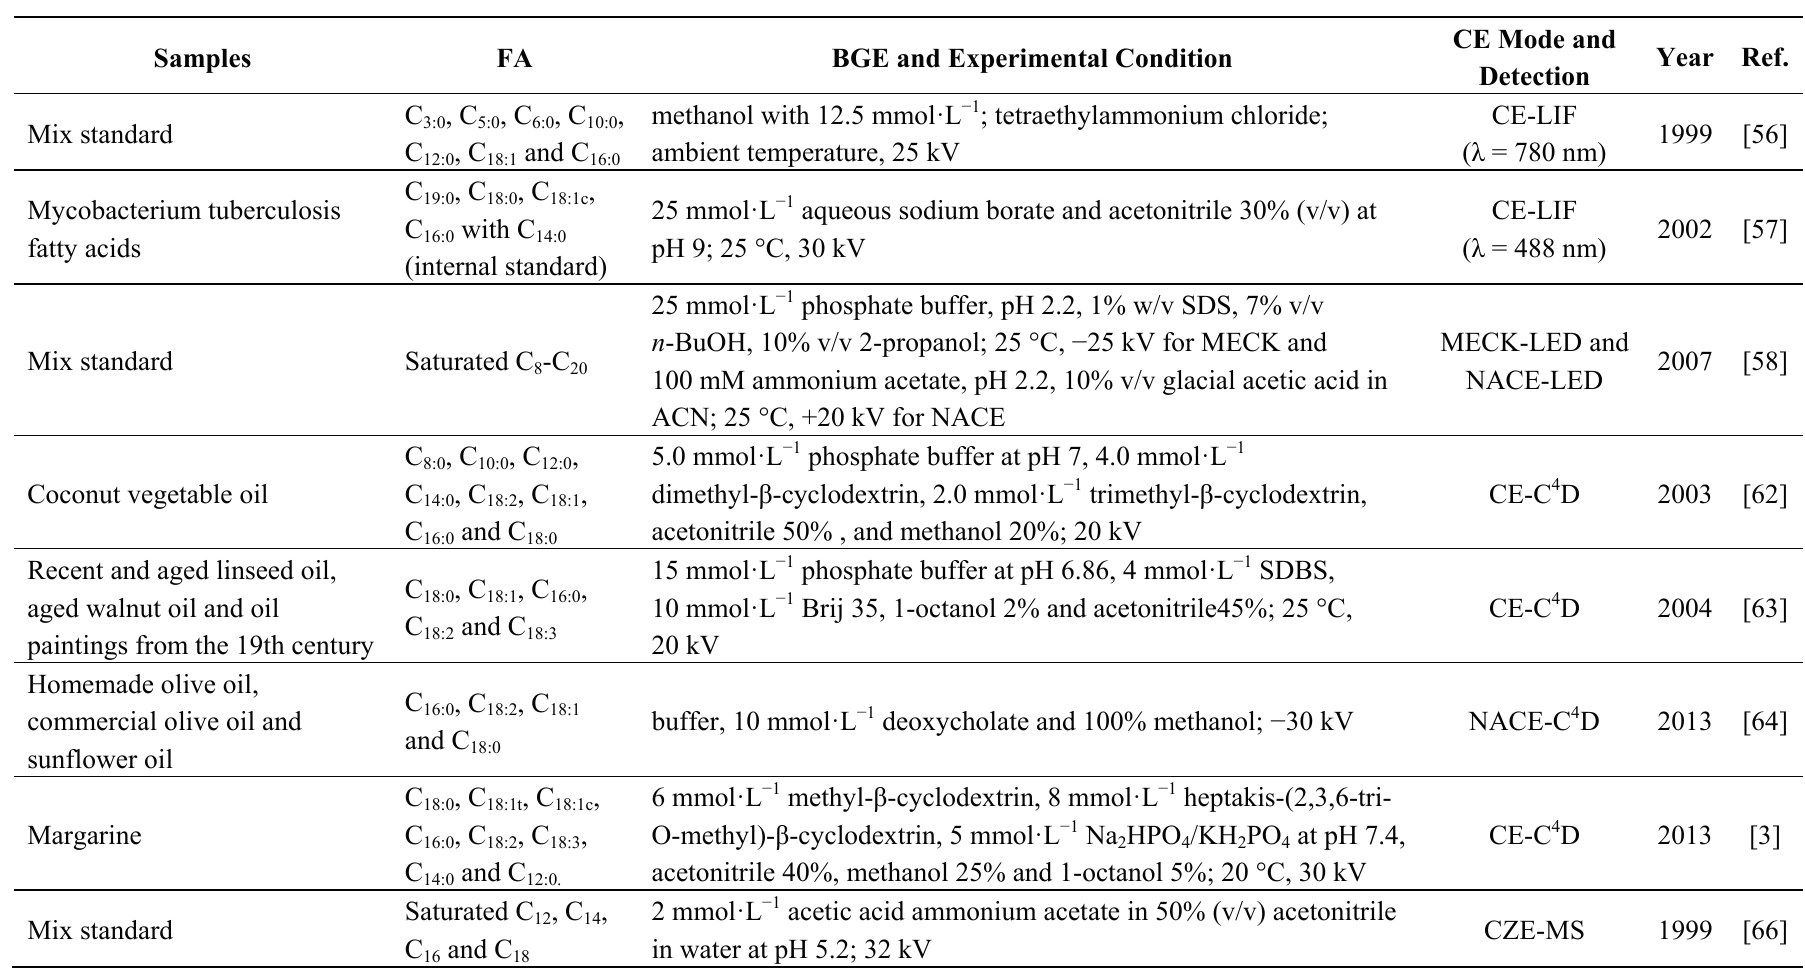
Table 3. Experimental condition, BGE and FA in different samples using LIF, LED, C 4 D and MS detection with different CE modes.